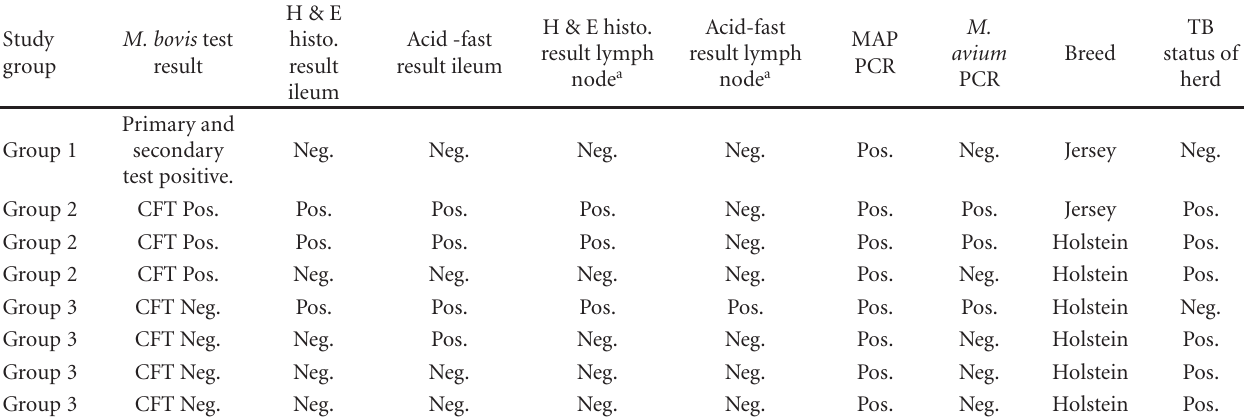
Table 2: Summary of pathology and PCR results in MAP infected animals.